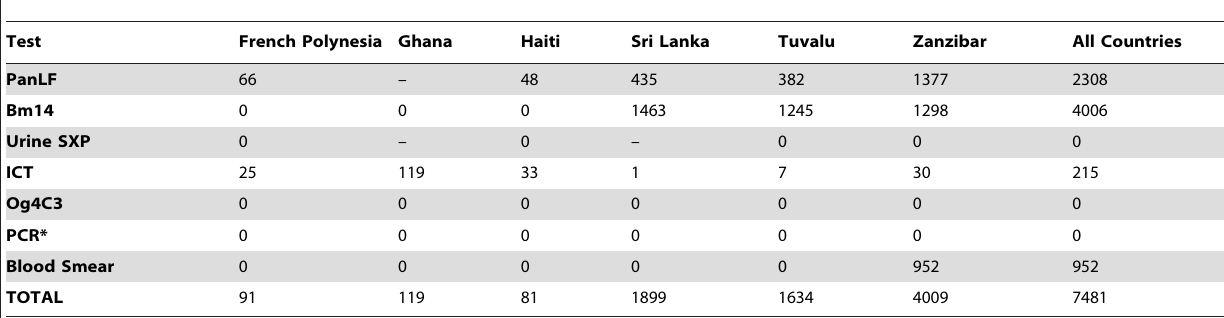
Table 5. Invalid or indeterminate test results by country (excluded from remaining analyses).